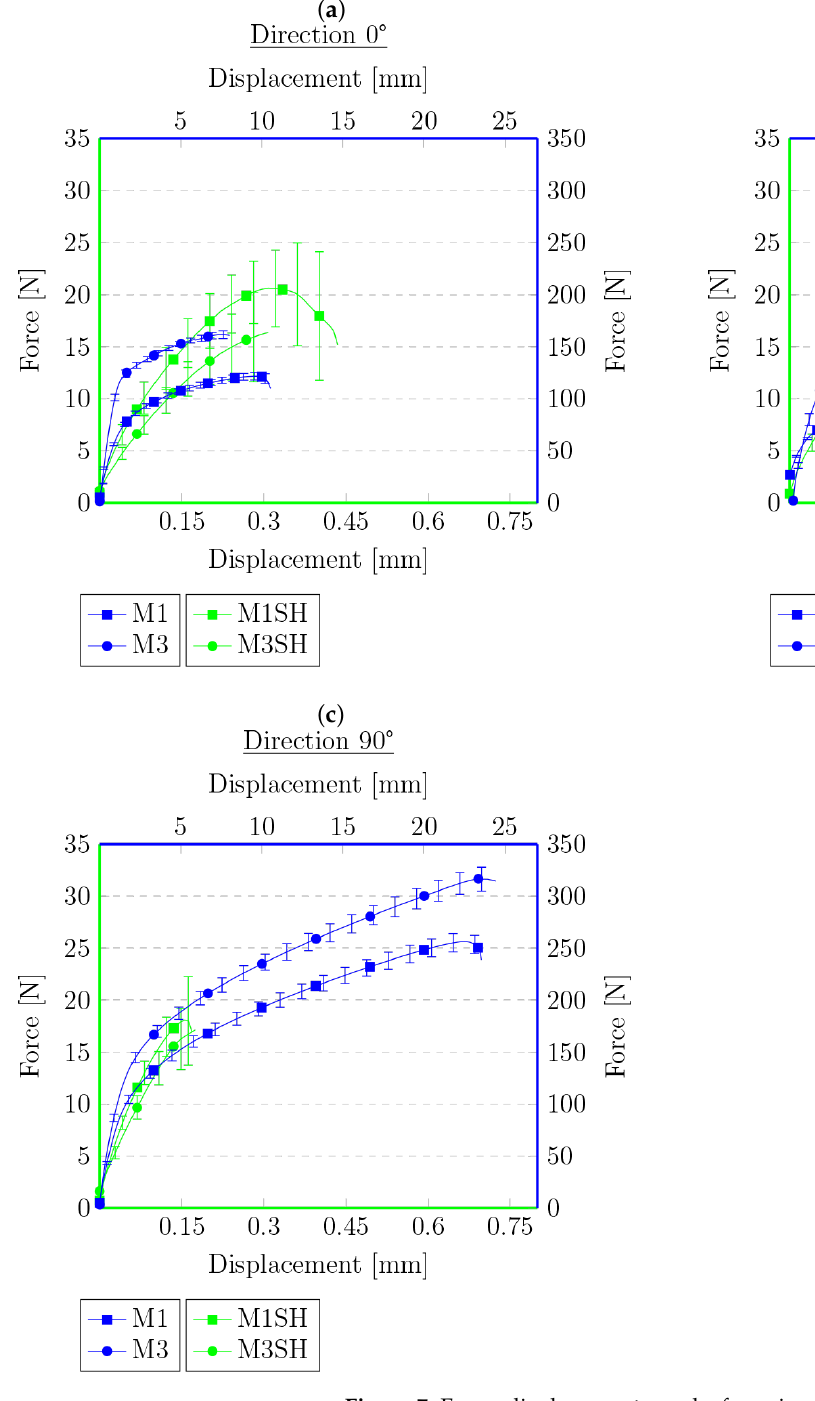
Figure 7. Force–displacement graphs for primary samples (blue) and samples cut with a knife and heated (green) with respect to the angle of reinforcement relative to the sample’s longitudinal